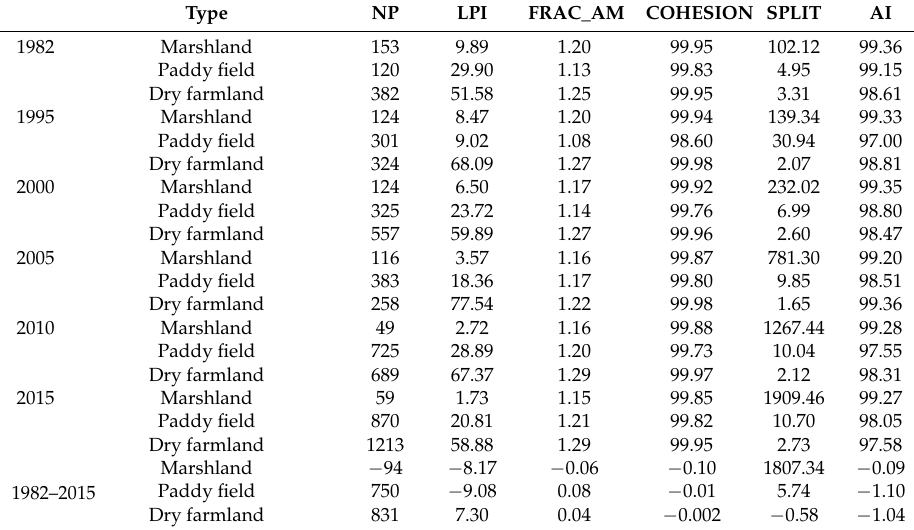
Class-level metrics for marshlands, paddy fields and dry farmlands in the Naoli River catchment.